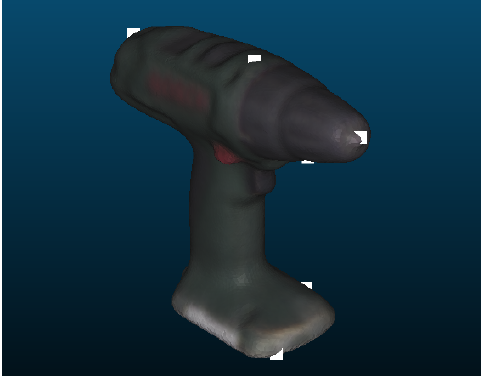
Figure 4. Driller.